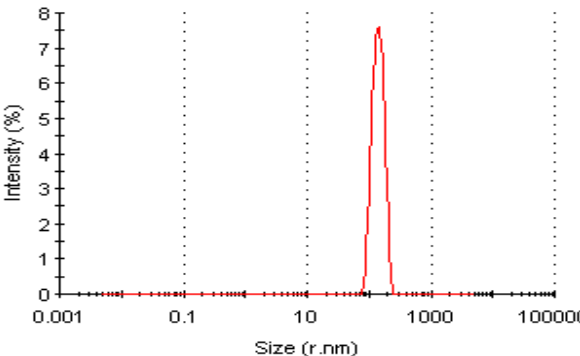
Figure 5. DLS profile of purified lip LSK25 at 25 °C, a single sharp peak indicating the monodispersity of the protein molecule .